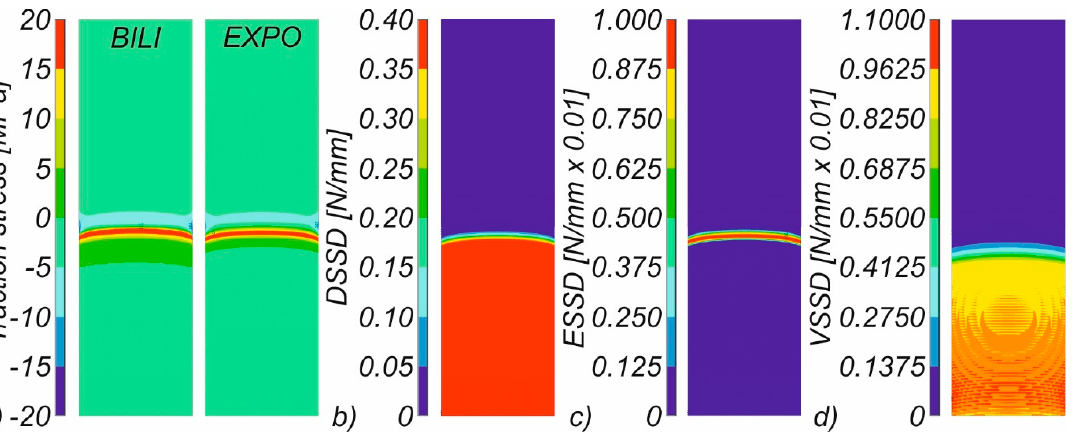
Figure 11. Contour maps of: traction stress ( a ); damage strain energy density ( b ); elastic strain energy density ( c ); and visco-regularization strain energy density ( d ).